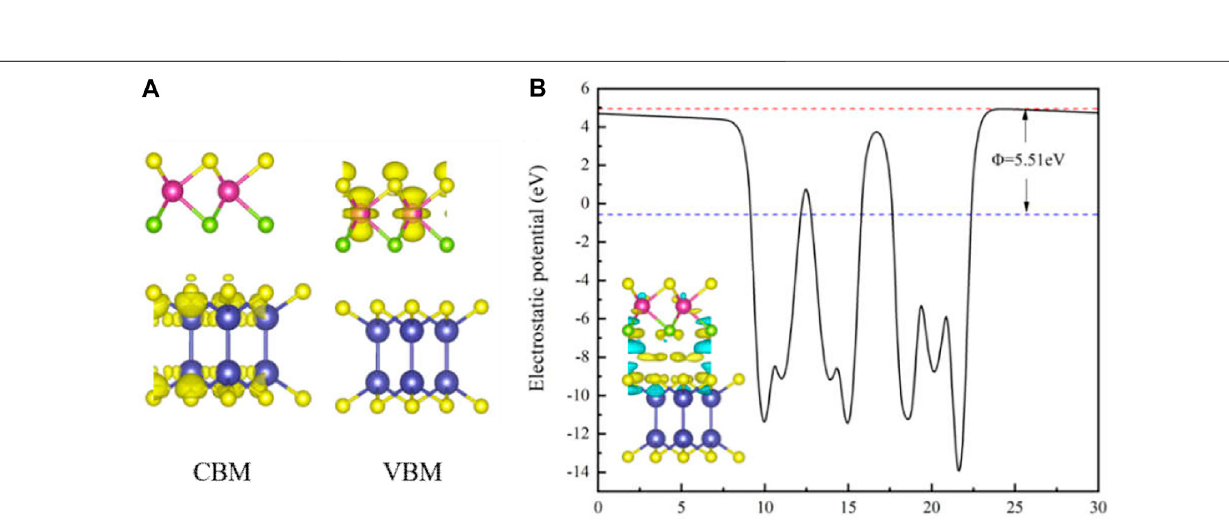
Frontiers in Chemistry |